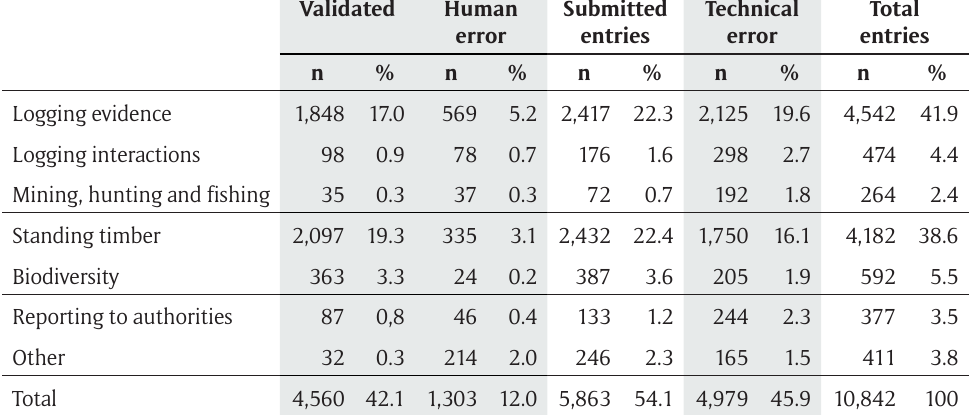
Table 1: Data on forest crimes and forest resources collected by the Prey Lang Community Network in Prey Lang, Cambodia, using the Prey Lang app from 1 Feb. 2015 till 31 Jan. 2017. Data are shown within the three main categories: Illegal activities (top), existing resources and biodiversity (middle), and interactions with authorities (bottom). For each category is shown the number of validated, human error rejected, and technical error rejected entries, along with the number of submitted entries (validated entries + human error rejected entries) and total entries (submitted entries + technical error rejected entries). % are percentages of the total number of